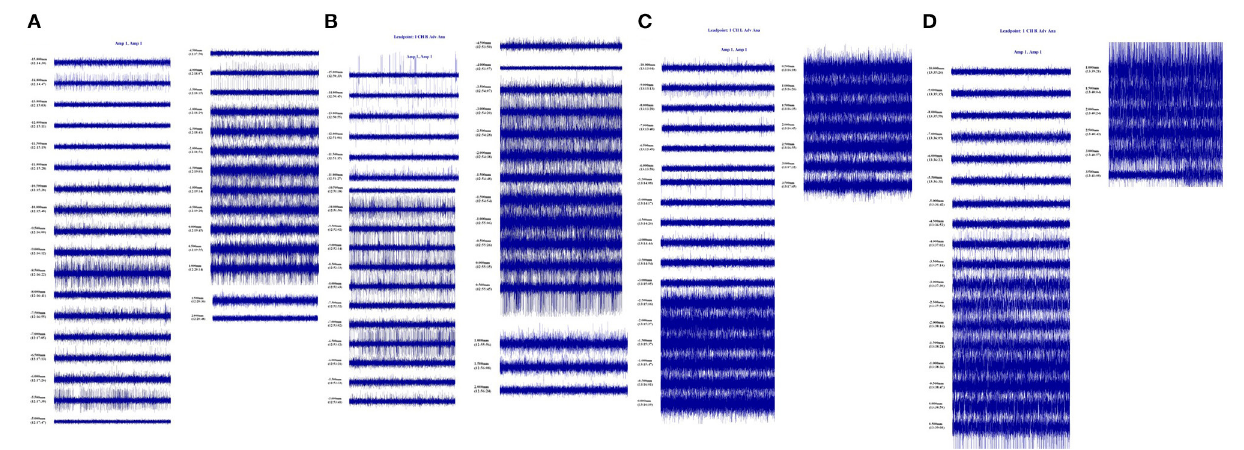
FIGURE 3 | Intraoperative microelectrode monitoring was recorded. (A) GPi on the left: during the monitoring process, GPe electrical activity was recorded from 11.0mm above the target to 5.5mm above the target, GPi discharge was recorded from 4.0mm above the target to 1.5mm below the target, and the electrode was placed at 1.0mm below the target. (B) GPi on the right side: during the monitoring process, GPe electrical activity was recorded from 11.0 to 4.5mm on the target, and GPi discharge was recorded from 3.5 to 1.5mm below the target; The electrode was placed 1.0mm below the target. (C) left STN: electrical activity of STN is recorded from 2.5mm above the target to 3.5mm below the target during monitoring: electrode is placed at 3.0mm below the target. (D) Right STN: electrical activity of STN was recorded from 4.0mm above target to 3.0mm below target during monitoring; The electrode was placed 2.5mm below the target.